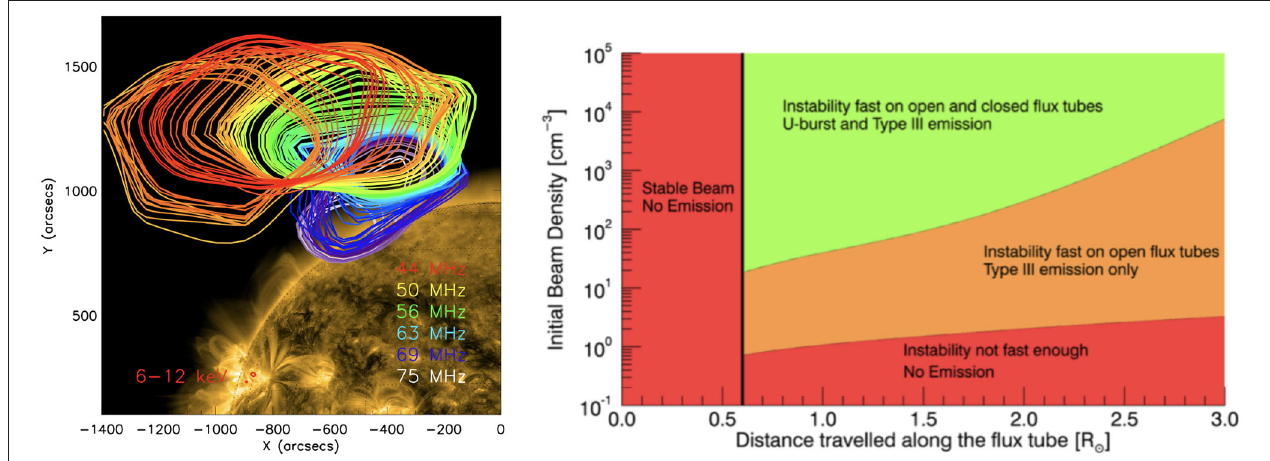
FIGURE 5 | Left : LOFAR contours of a U-burst tracing out a large coronal magnetic loop. The co-temporal X-ray source is shown with a background of the 171 Angstroms Sun. Right : A schematic showing how electron beams require long flux tubes and/or high densities to produce J/U-bursts. Adapted from Reid and Kontar (2017a)